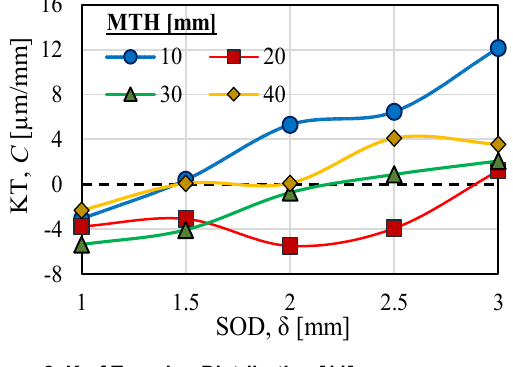
Figure 8. Kerf Tapering Distribution [11]